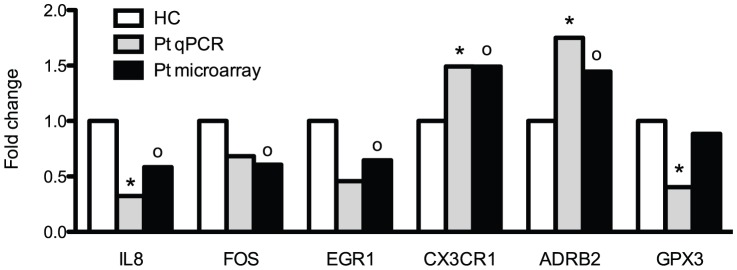
Validation of differentially expressed genes on microarray by quantitative polymerase chain reaction.*P-value<0.05 for gene expression in patients at baseline vs. healthy controls as determined with qPCR technique; oP-value<0.05 for gene expression in patients at baseline vs. healthy controls as determined with microarray technique. ADRB2 adrenergic receptor, β2; CX3CR1 chemokine (C-X3-C motif) receptor 1; EGR1 early growth response 1; FOS FBJ murine osteosarcoma viral oncogene homolog; GPX3 glutathione peroxidase 3; IL8 interleukin 8; qPCR quantitative polymerase chain reaction.